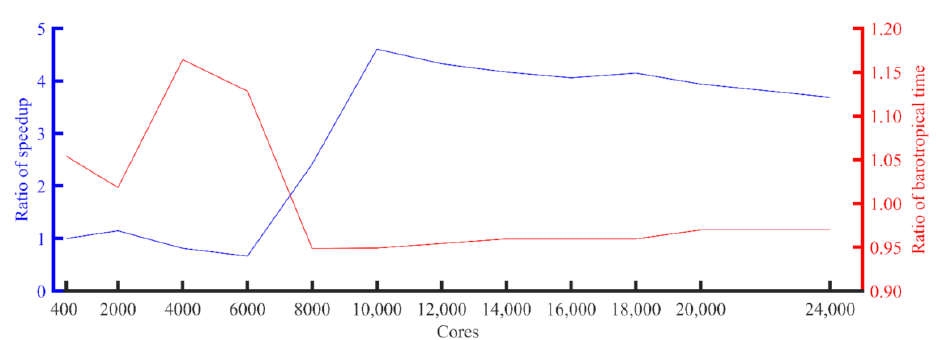
Figure 8. Ratio of the speedup of the NEMO model using the CA-PCG and PCG solvers (blue line) and the ratio of the percentage of the barotropic time of the total execution time using the CA-PCG and PCG solvers (red